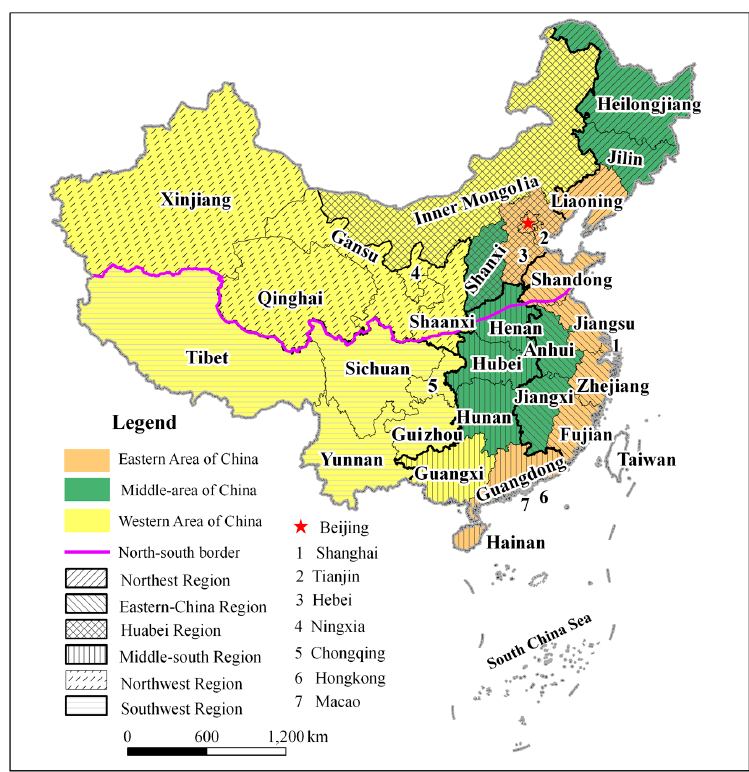
Figure 1. Map of the study area.